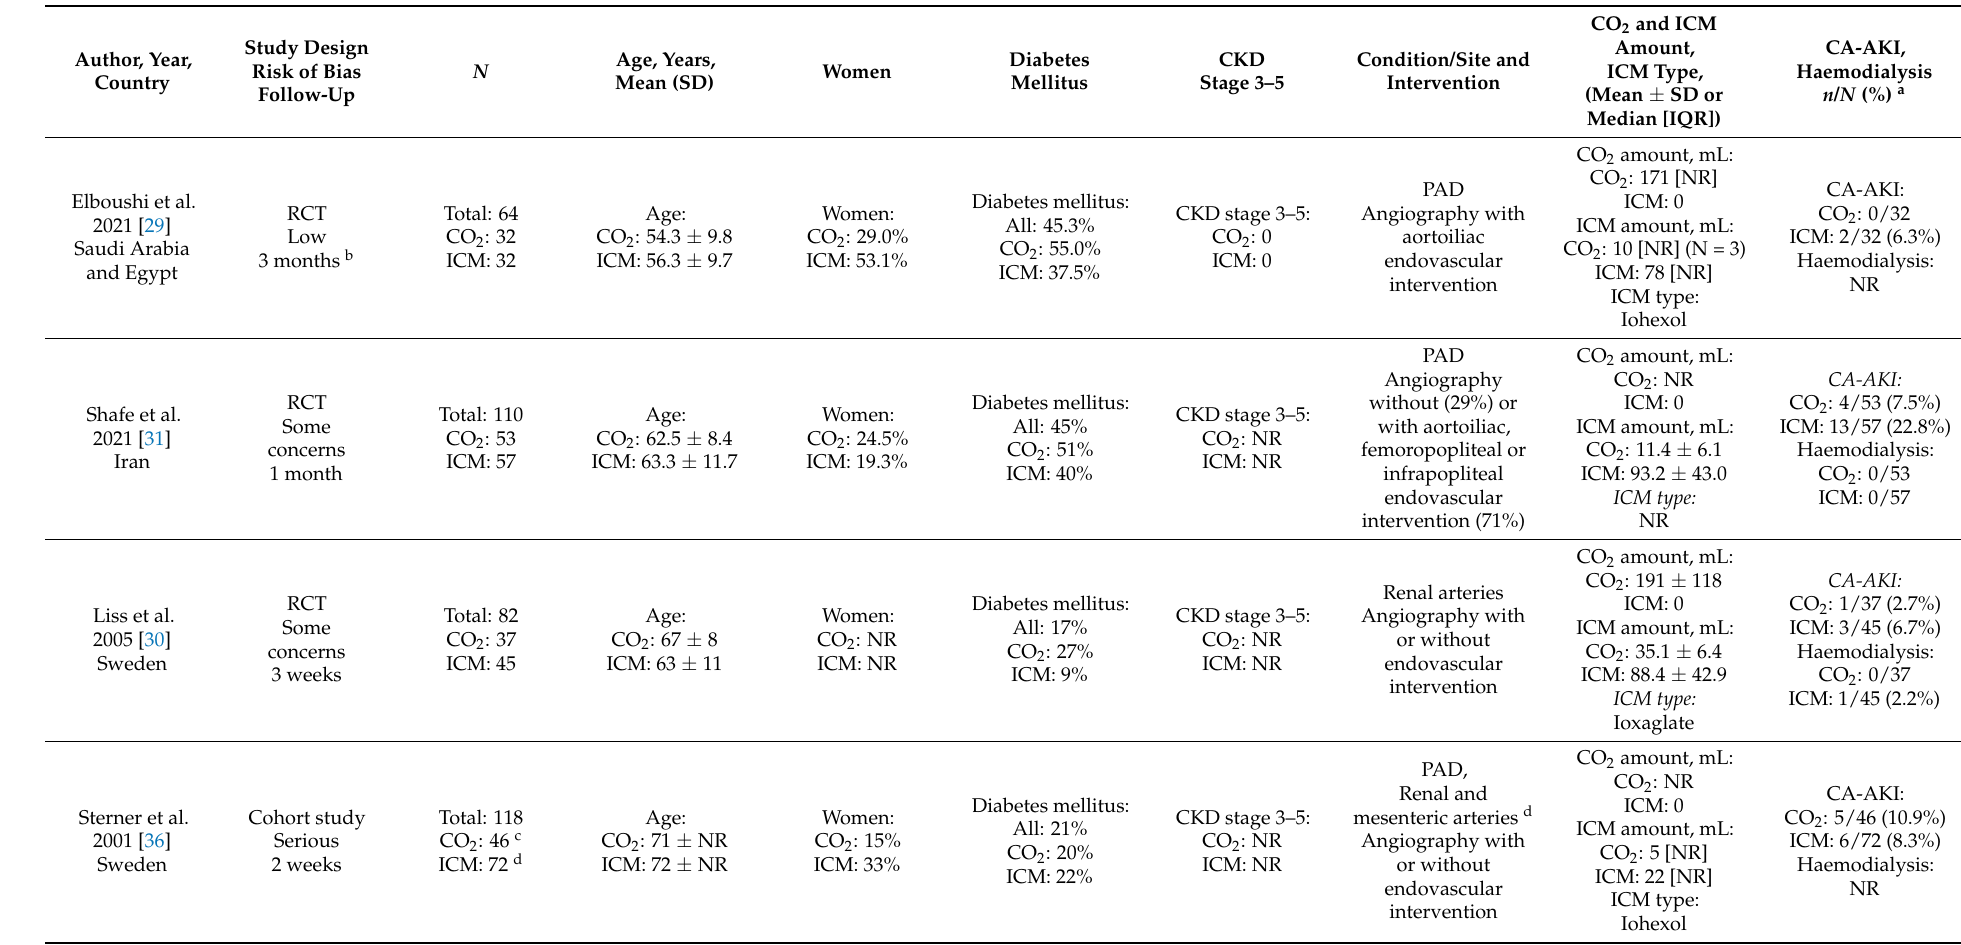
Table 1. Key characteristics and outcome of the included